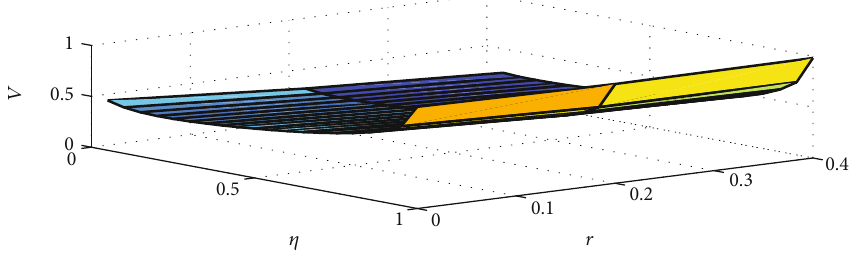
Figure 11: Plots of the smallest eigenvalue V (Equation (37)) versus η and r for A = 100 and κ = 0 : 8